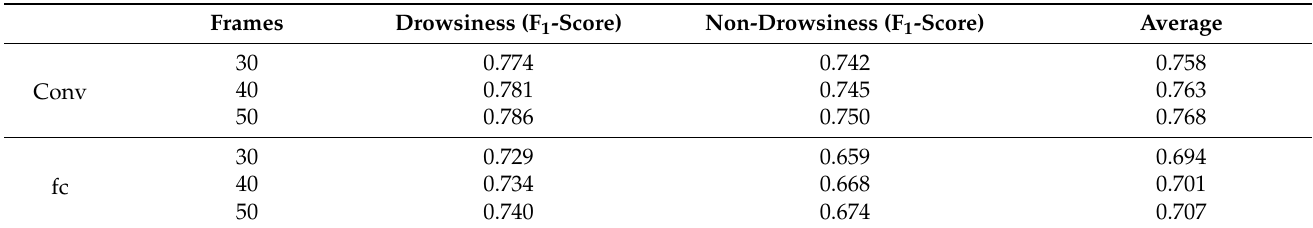
Table 3. The evaluation dataset of the NTHU-DDD dataset was used to compare the average accuracy of the drowsiness and non-drowsiness